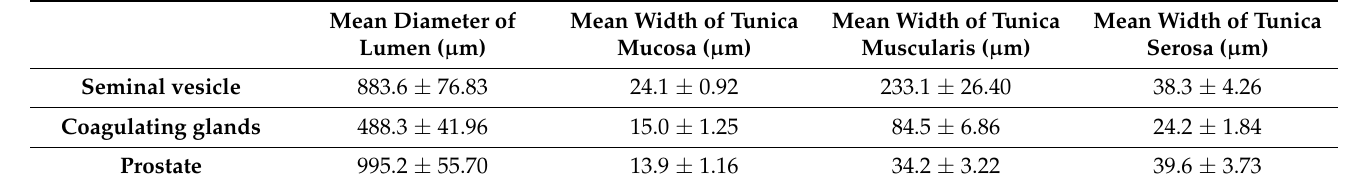
Table 2. The mean microscopic measurements of some of the components of the male reproductive tract of the agouti ( D. leporina ), according to Mollineau et al. [22]. Mean Diameter of Mean Width of Tunica Mean Width of Tunica Mean Width of Tunica Lumen ( µ m) Mucosa ( µ m) Muscularis ( µ m) Serosa ( µ m) Seminal vesicle 883.6 ± 76.83 24.1 ± 0.92 233.1 ± 26.40 38.3 ± 4.26 Coagulating glands 488.3 ± 41.96 15.0 ± 1.25 Prostate 995.2 ±